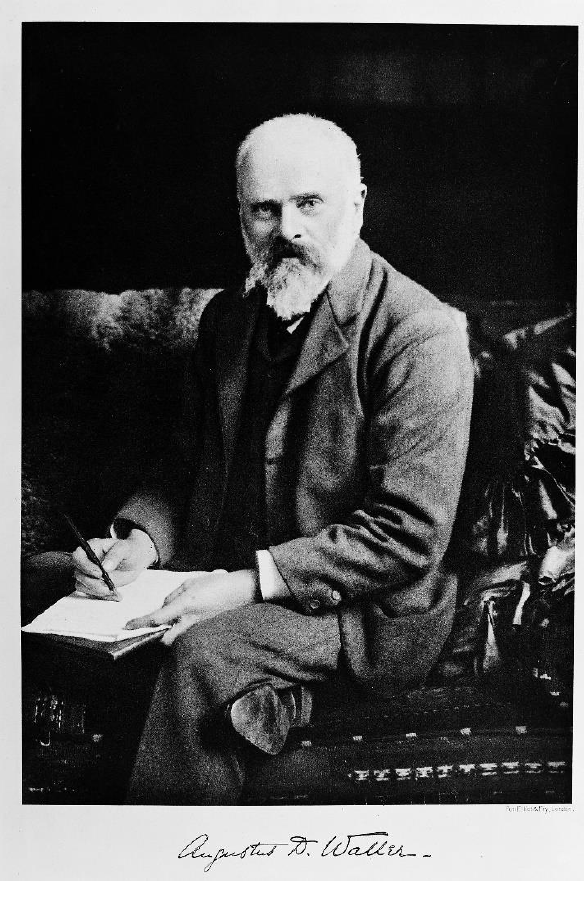
Figure 1 : Augustus Desiré Waller [10].